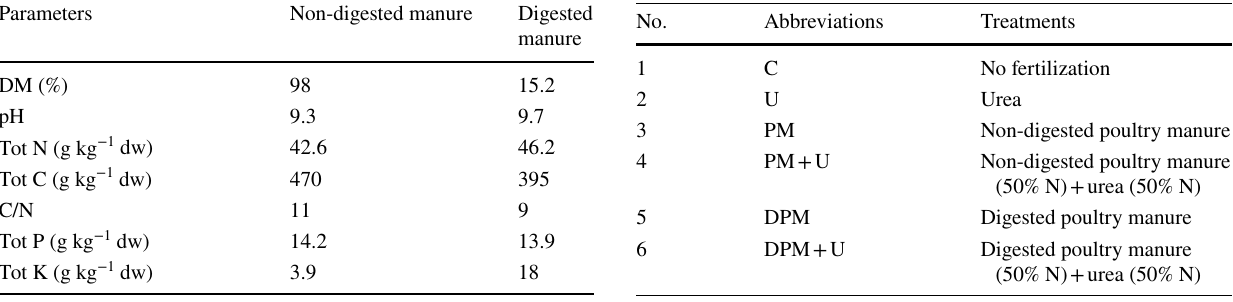
Table 3 Treatments used in the germination experiment